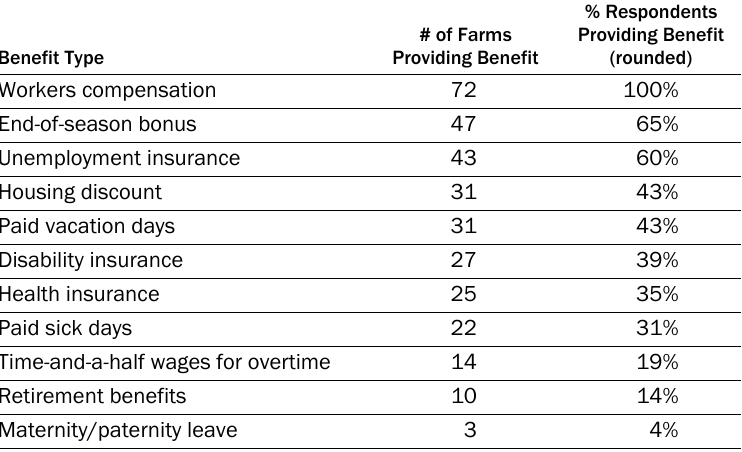
Table 5. Number and Percentage of Farmers Indicating Benefits by Type Given to Benefits-Eligible Workers, 2012 ( N =72)